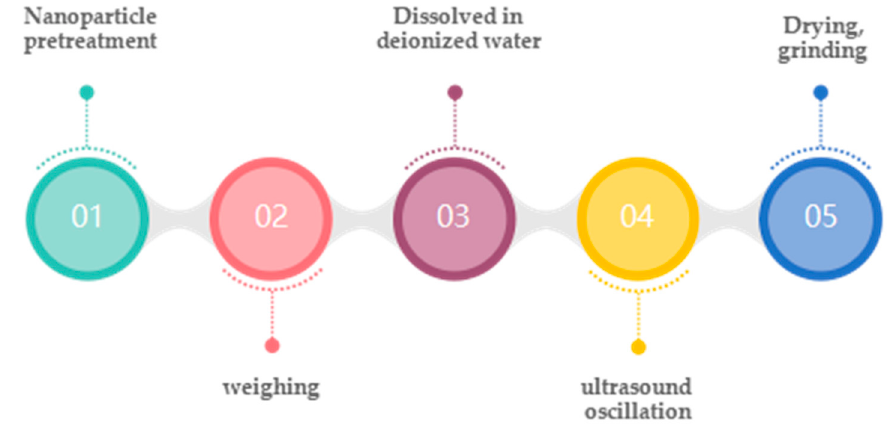
Figure 3. Two-step preparation of molten salt nanofluidic flow [57].